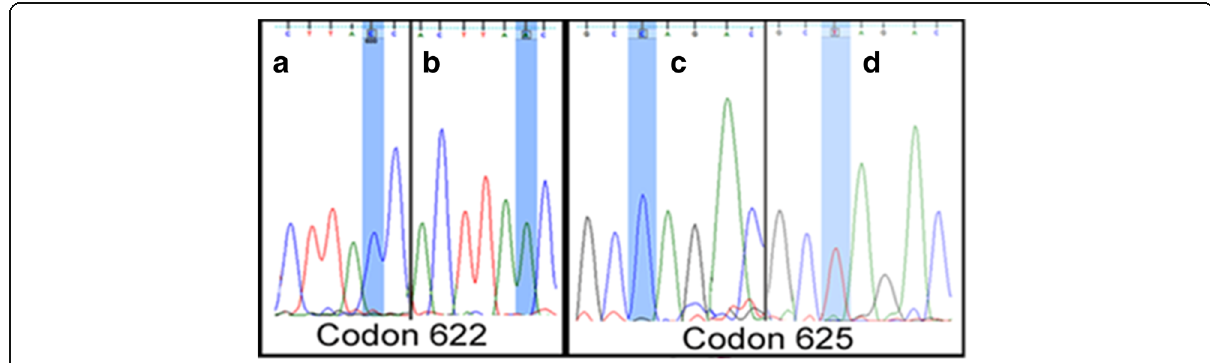
Fig. 2 Different Mutation in the exon 14 (g.127576C > A, g.127583C > T) of APC protein. a Wild type codon 622 (TAC) in adjacent normal sample, b Mutant type codon 622 (TAA) in tumor sample, c Wild type codon 625 (CAG) in adjacent normal sample, d Mutant type codon (TAG) in tumor